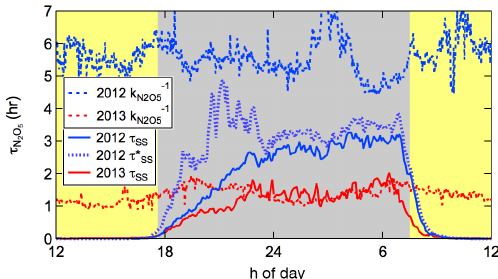
Figure 7. Lifetimes of N 2 O 5 , calculated using the production rate of NO 3 (solid lines), the lifetime calculated using the method of McLaren et al. (2010) for 2012 (short dashed line; see text), and uptake to aerosol using an uptake coefficient of γ = 0 . 02 (dashed lines). In 2012 we expect that the calculation gives 77% of the ac- tual lifetime, due to the system not reaching equilibrium at the end of the night. The McLaren method, based on explicit inclusion of the time derivative for N 2 O 5 , partially corrects for this effect, espe- cially early in the night. An uptake coefficient of γ = 0 . 026 would bring the P(NO 3 ) and aerosol calculations in 2012 into agreement. The observed lifetimes from P(NO 3 ) include deposition, but the cal- culated curves do